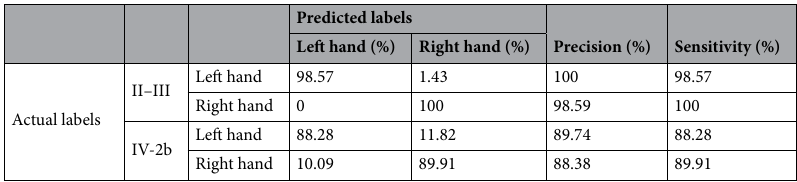
Table 11. Confusion matrix, sensitivity, and precision for best accuracy.